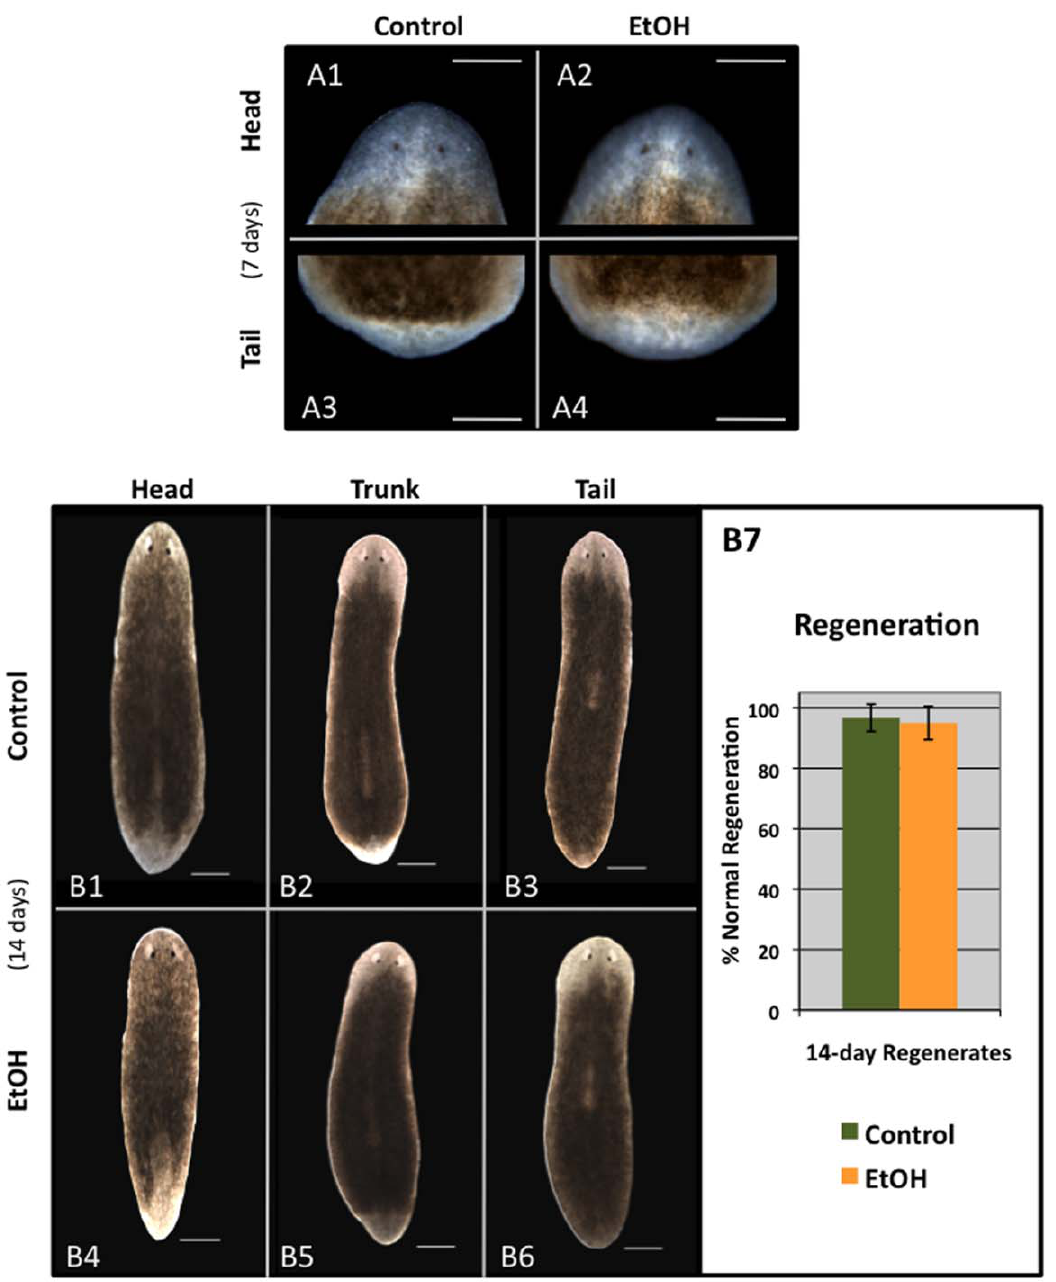
Figure 5. A 3% Ethanol Treatment Does Not Affect Regeneration. Regeneration Morphology . Worms were washed out of a 1-hour ETOH treatment and immediately cut into thirds (creating head, trunk and tail fragments). ( A ) Analyses at 7 days of regeneration. No delays in either eye development (A1–A2) or blastema formation (A3–A4) were observed between control (A1, A3) and EtOH-treated (A2, A4) regenerates. Trunk fragments shown. Scale bars=250 m m. ( B ) Analysis at 14 days of regeneration shows that untreated control (B1–B3) and EtOH-treated (B4–B6) worms equally form blastemas and regenerate with correct anterior/posterior polarity and patterning. Scale bars=500 m m. (B7) There is no significant difference between control (n=58) and EtOH-treated (n=57) regenerates (p=0.78). Error bars reflect 95% Confidence Intervals. Anterior is up. doi:10.1371/journal.pone.0015310.g005 (treated worms that had regained movements) were assayed for the (Figure 7A3). This recovery of cilia is consistent with the timing of gross movement recovery (Figure 4C). These data suggest that presence or absence of cilia in the heavily-ciliated head region EtOH treatment does remove epidermal cilia from planarians, (Figure 7A). Control, untreated worms had clearly visible cilia which contributes at least in part to their immobilization. (Figure 7A1). This dense ciliated layer was no longer observed in EtOH-immobilized worms, with most cilia now lost (Figure 7A2). To corroborate these data, control and EtOH-treated worms When EtOH-immobilized worms had recovered (3–4 hours after were fixed and stained with an acetylated tubulin antibody (Figure 7B), which labels planarian epidermal cilia [25,26], as well washing out of EtOH), cilia were once again observed